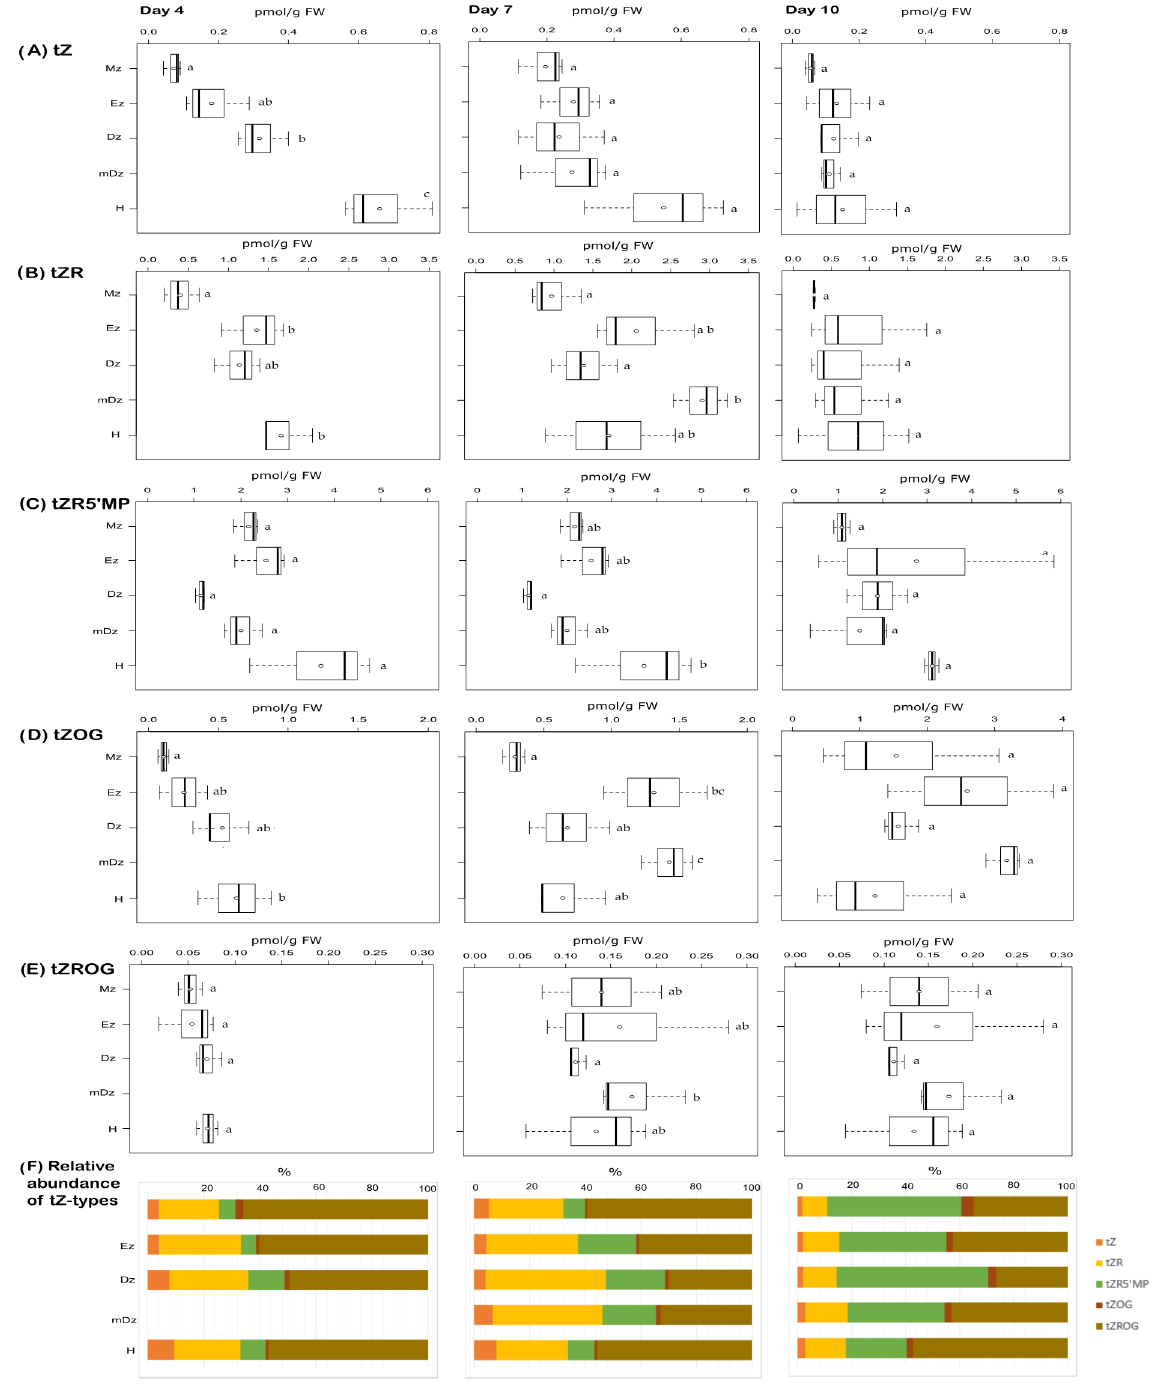
Figure 4. Quantification of tZ-type cytokinins in hypocotyl and developmental root sections of cacao seedlings. Levels of ( A ) trans-zeatin (tZ), ( B ) trans-zeatin riboside (tZR), ( C ) trans-zeatin riboside-5 (cid:48) -monophosphate (tZR5 (cid:48) MP), ( D ) trans- zeatin-O-glucoside (tZOG), and ( E ) trans-zeatin riboside- O -glucoside (tZROG) were determined from the samples described in Figure 1. The levels of trans-zeatin-7-glucoside (tZ7G) and trans-zeatin-9-glucoside (tZ9G) were below the limit of detection in all samples. The dark vertical line indicates median; boxes represent 25th and 75th percentiles; horizontal linesrepresentmaximum and minimum values; circlesindicate mean values. Significant variations in concentration determined by Welch’s test post hoc, p ≤ 0.05 among hypocotyl and primary root sections are indicated by letters, n = 3 independent biological replicates; FW = fresh weight. ( F ) Percent proportion of each tZ-type cytokinin